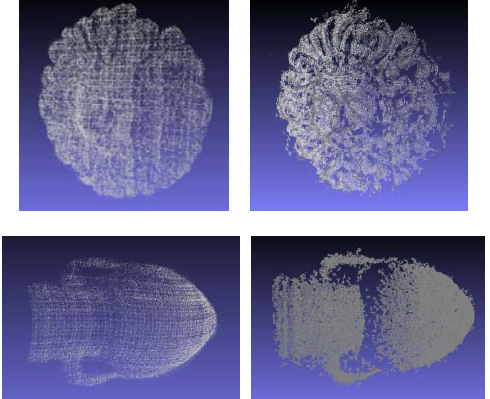
Figure 8: Point clouds at level T1 for active stereo (column left) and passive stereo (column right): the 3D reconstructions